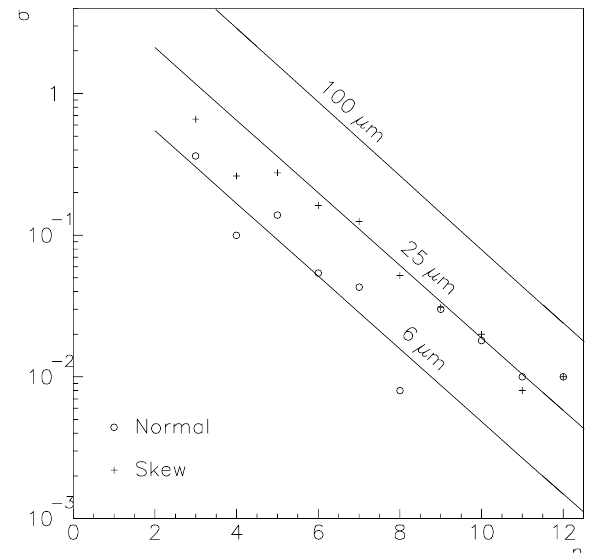
FIG. 8. rms of the multipoles along the axis for the LHC quadrupole prototype SSS3 (markers) and scaling law for dif- ferent amplitudes of random displacements d (solid line).